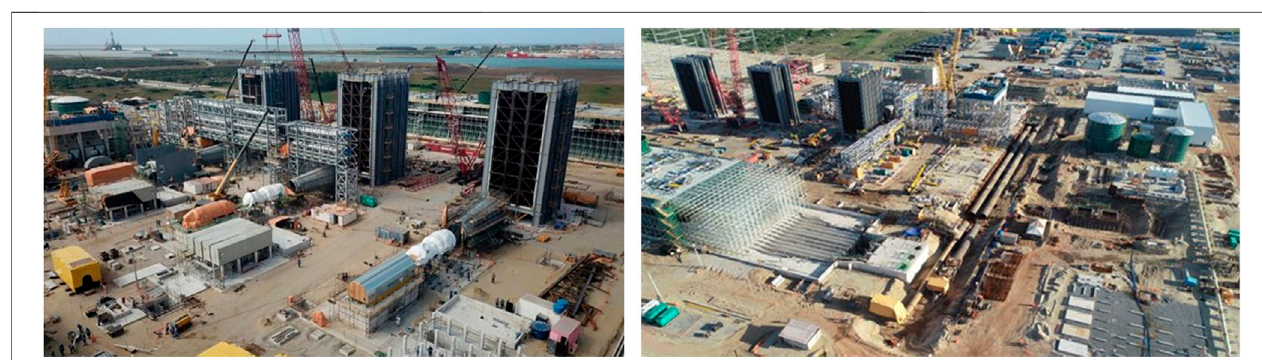
FIGURE 2 | Aerial views of the project (source: project detailing